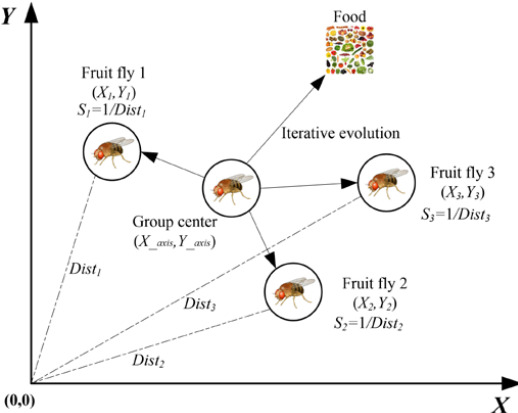
Figure 1. Process of foraging behavior for a fruit fly group.